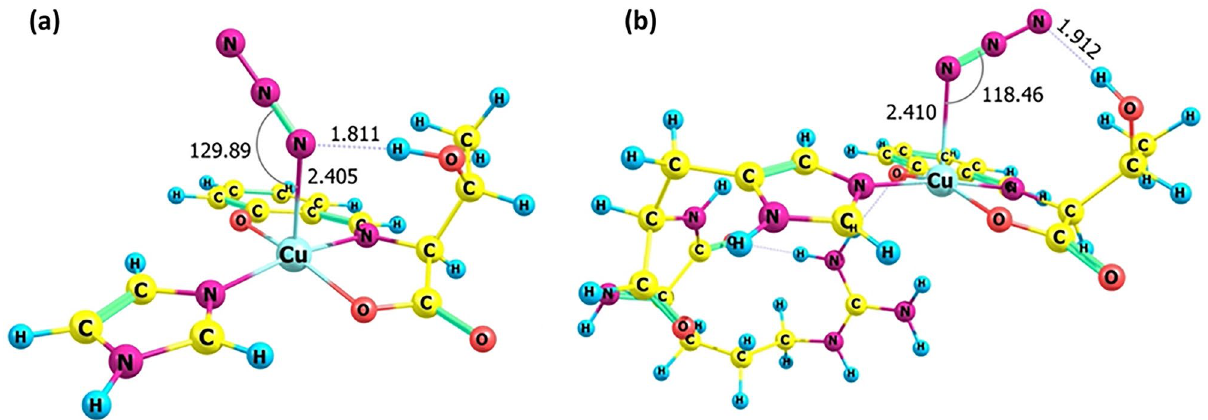
Figure 10. Optimized structures of ( a ) CuST-Imi and ( b ) CuST@lysozyme with N 3 ion. Selected bond lengths (Å) and angles (°) are